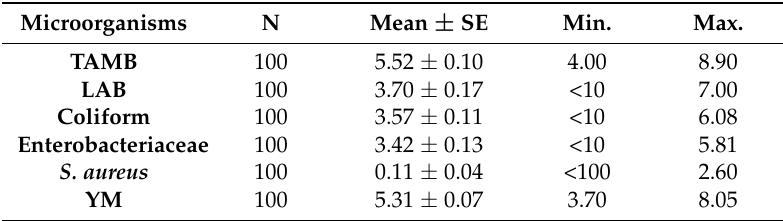
Table 1. Results of microbial counts (in log CFU/g) in herby cheese samples.